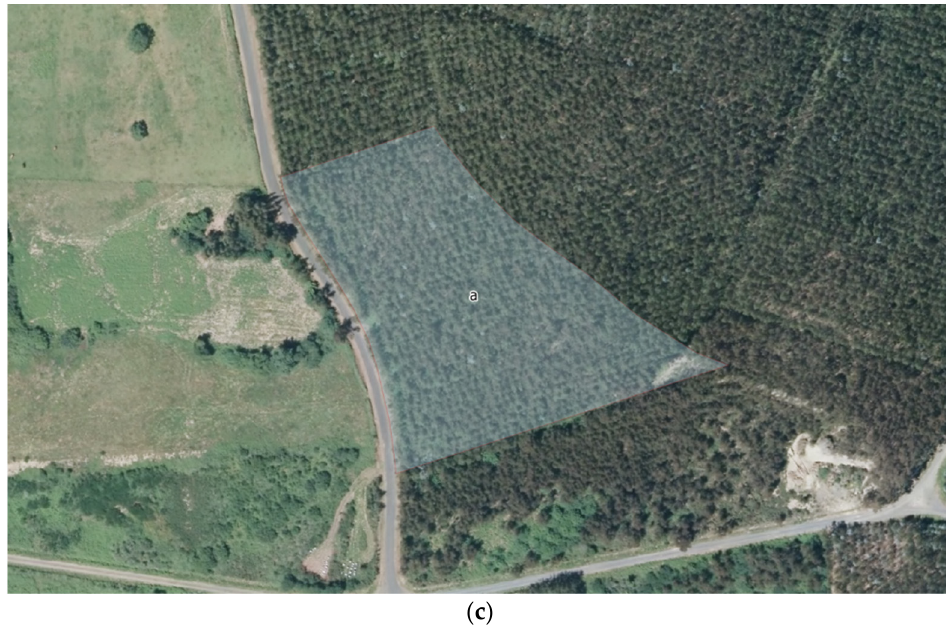
Figure 6. ( a , b ) Spatial and temporal variations in NDVI in a pilot plot of E. globulus with an area of 1.08 ha. ( c ) Land uses: E. globulus .